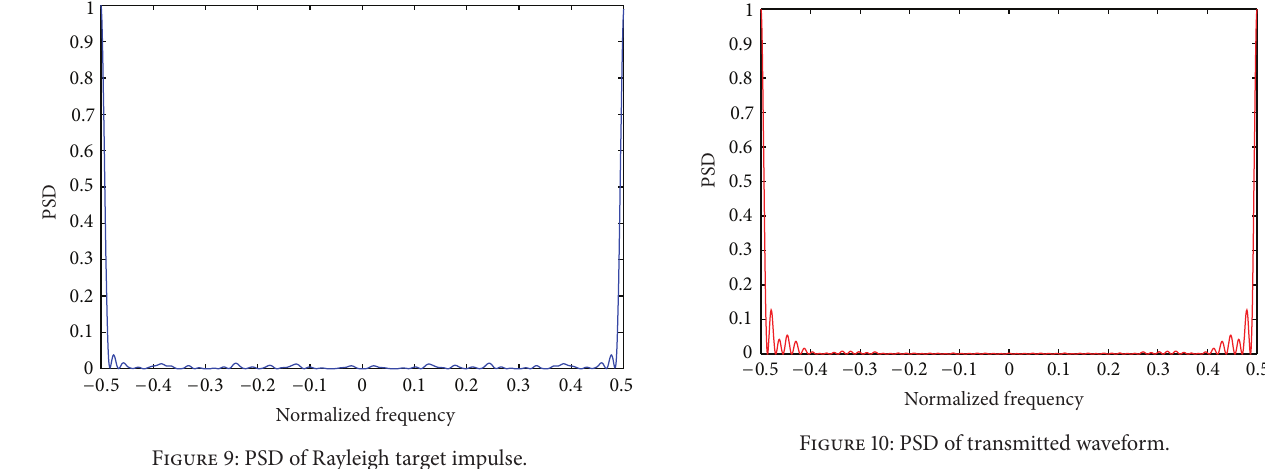
Figure 9: PSD of Rayleigh target impulse.